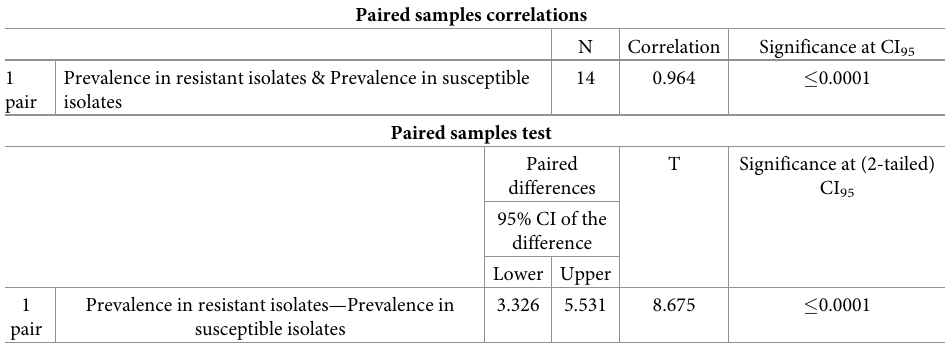
Table 9. Paired samples correlations for prevalence of resistance genes in resistant and susceptible